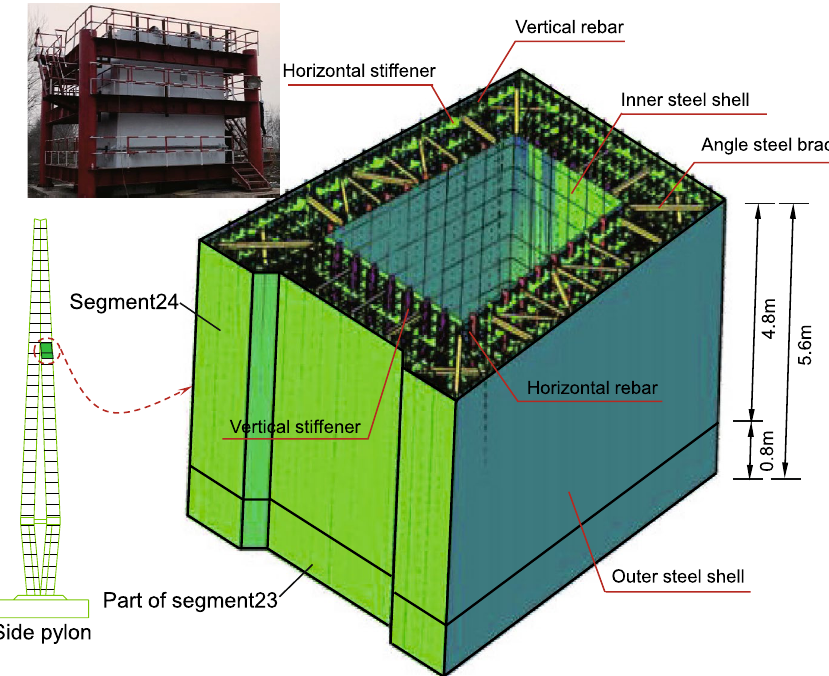
Figure 9. Full scale segment